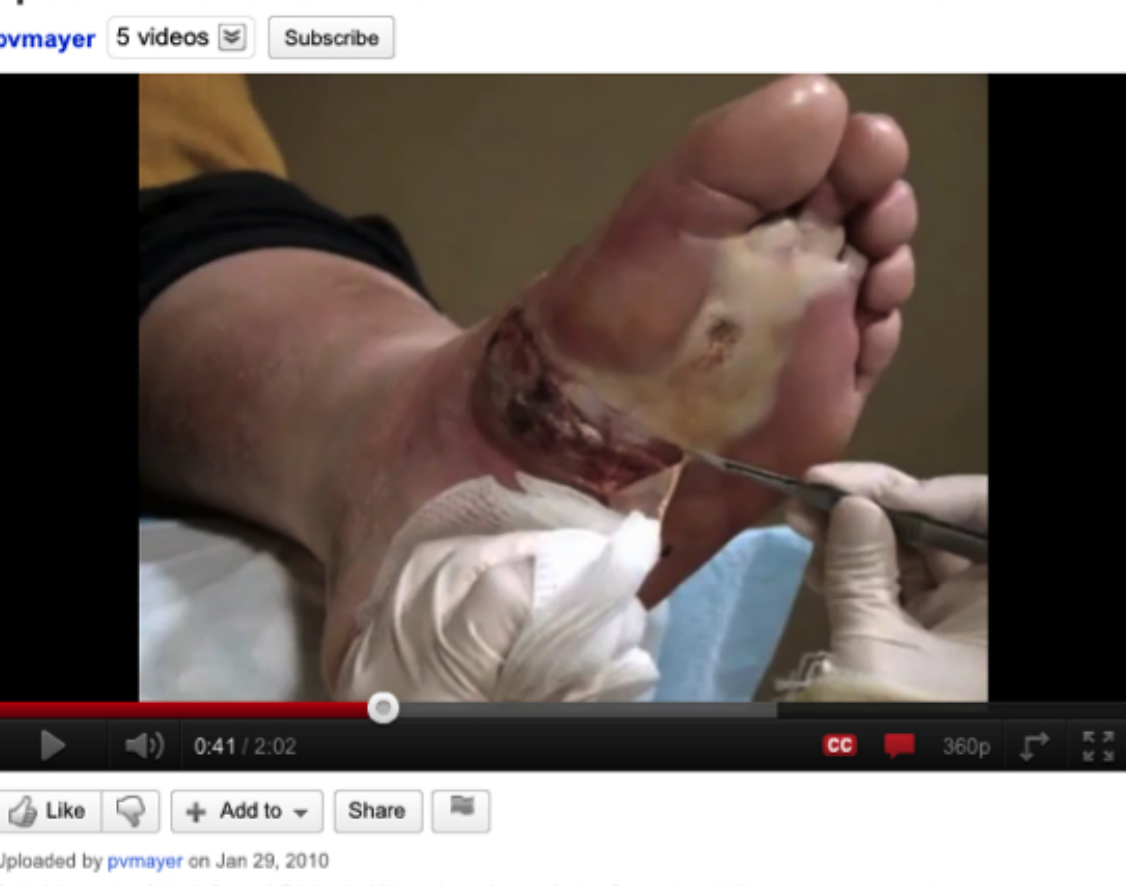
estimates health-related trust and not general trust on YouTube. Figure 10. Highly ranked YouTube video about diabetic foot featuring an infected